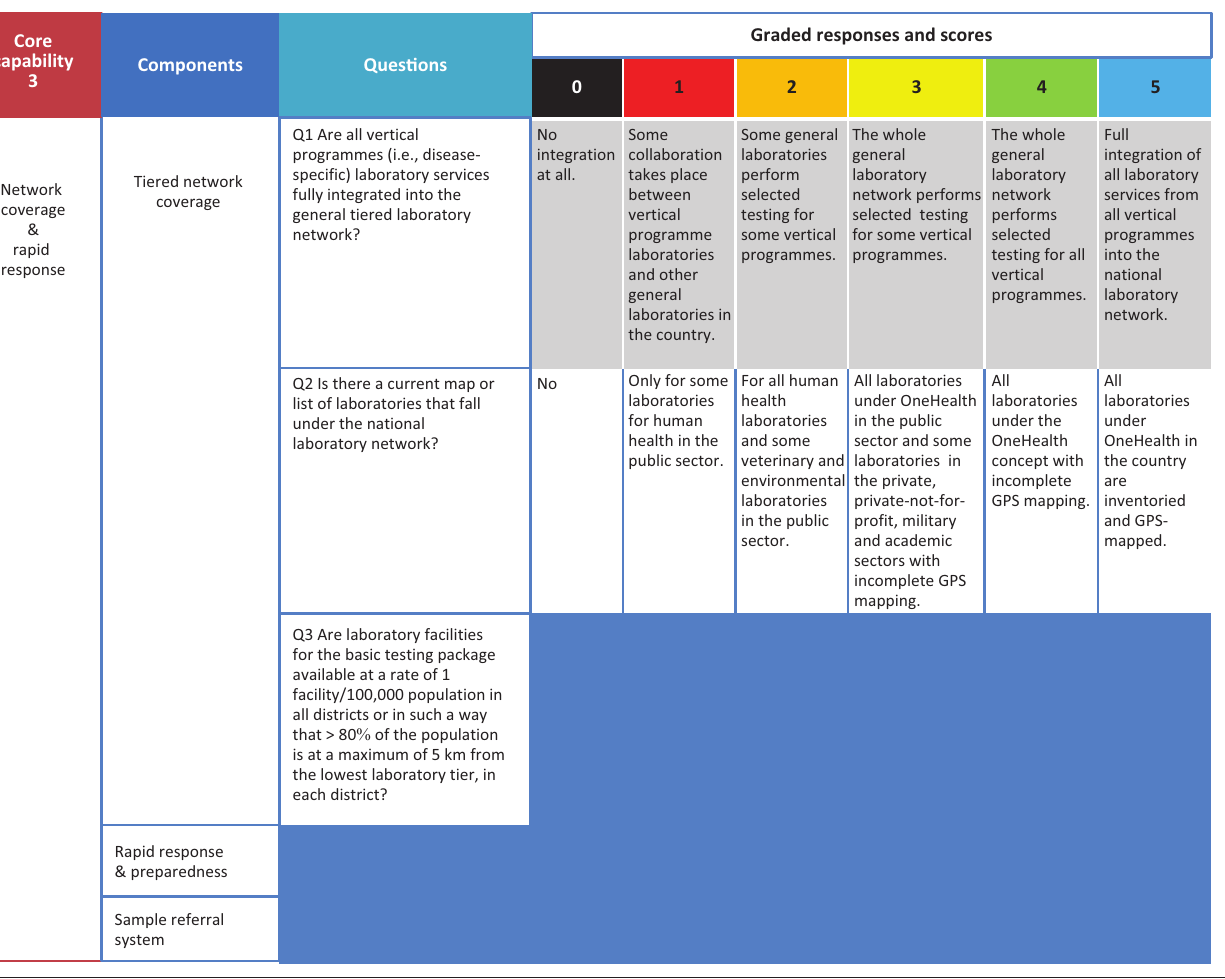
FIGURE 2: Example organisation of core capabilities, components and indicators on LABNET